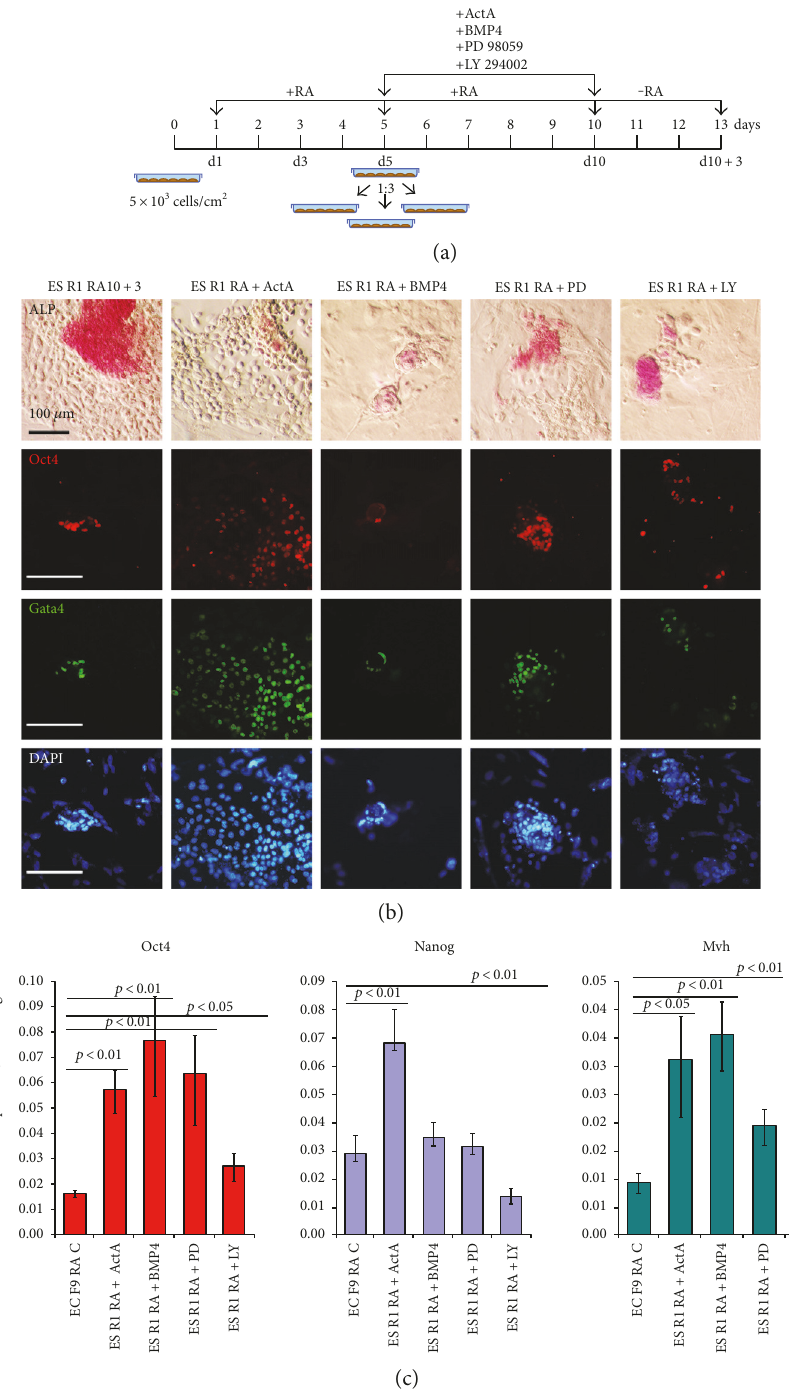
Figure 5: Stimulation of the Activin A/Nodal and BMP signaling pathways and inhibition of the MEK/ERK and PI3K/Act signaling pathways in ES R1 cells during the course of RA-induced di ff erentiation. (a) Design of experiments on the induced di ff erentiation of ES R1 cells with RA and exposure to Activin A, BMP4, PD98059, and LY294002. (b) ALP activity and Oct4 and Gata4 expression in di ff erentiating ES R1 cells after exposure to RA, Activin A, BMP4, PD98059, and LY294002 on day 3 after RA and additive withdrawal. Nuclei were counterstained with DAPI. ActA: Activin A; BMP: BMP4; PD: PD98059; LY: LY294002. Scale bar =100 μ m. (c) The expression of Oct4, Nanog, and Mvh in di ff erentiating ES R1 after exposure to RA, Activin A, BMP4, PD98059, and LY294002 on day 3 after RA and additive withdrawal. The gene expression levels of each gene in all experimental variants of di ff erentiating ES R1 cells were calculated relative to the gene expression levels in control ES R1 cells on day 3 after RA withdrawal (ES R1 RA10+3) and statistically evaluated relative to the gene expression levels in control EC F9 cells on day 3 after RA withdrawal (EC F9 RA10+3). The data are represented as the mean ± s.d.; signi fi cant di ff erences were estimated using